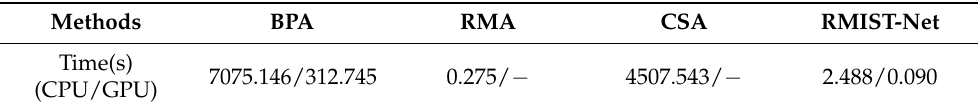
Table 6. Running time under different